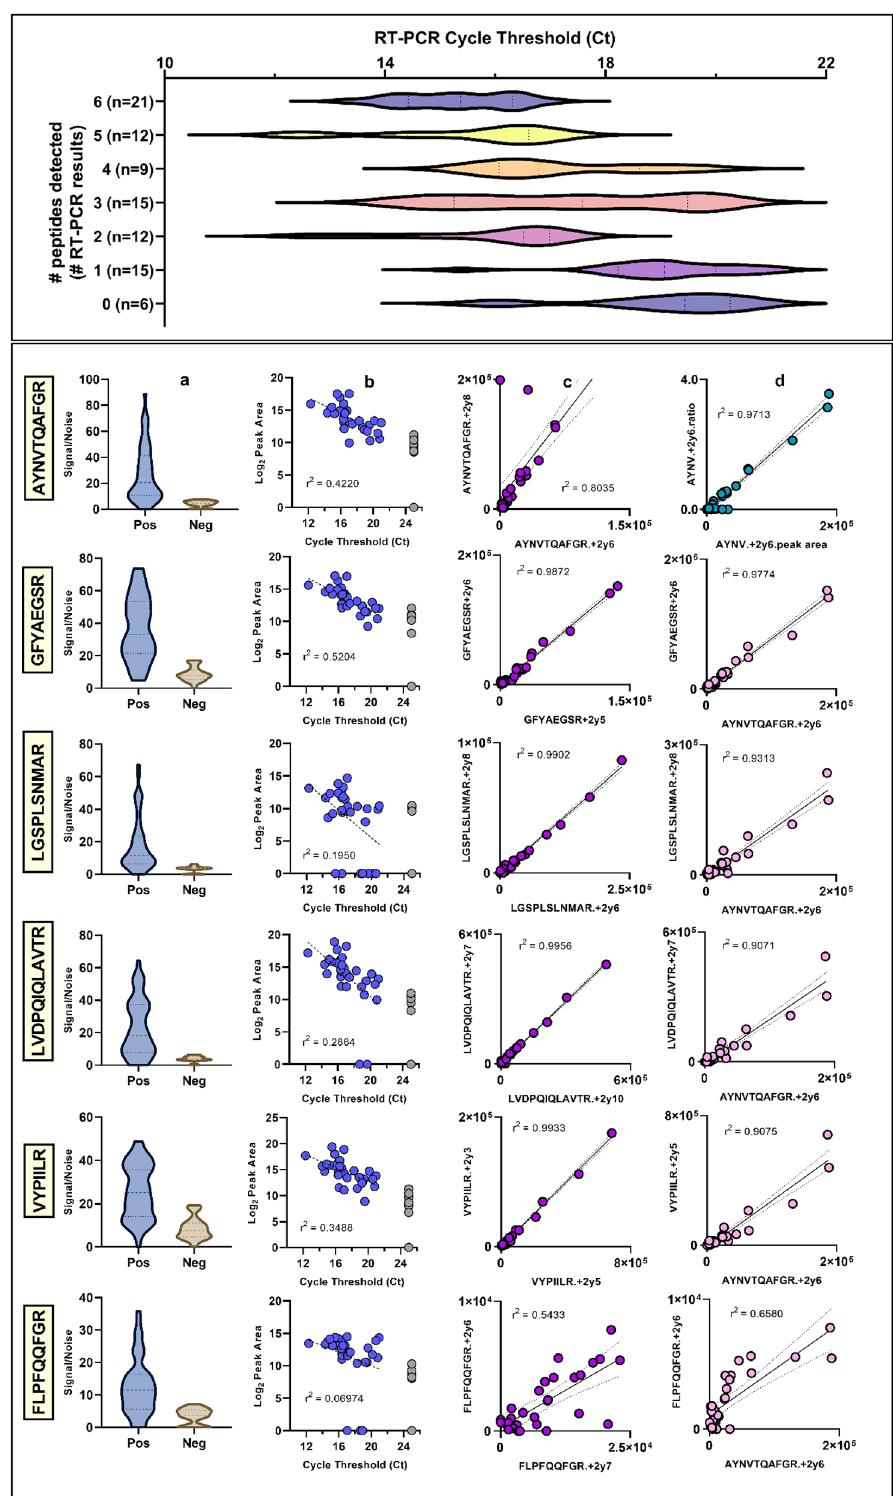
Figure 4. Targeted method performance for six peptides targeting 3 proteins from SARS-CoV-2. (Top panel) Spread of Ct values for 3 SARS-CoV-2 genes vs # peptides detected in clinical sample cohort 3. (Lower panel) From left; ( A ) Violin plot comparing software generated signal-to-noise ratio between positive (left) and negative (right) clinical specimens. ( B ) Correlation between reported N-gene Ct and peak area of the most intense MRM transition. Grey dots are peak areas detected in RT-PCR negative samples, assigned an arbitrary Ct of 25 for ease of reading. ( C ) linear regression of best two MRMs for each peptide for all RT-PCR positive samples. ( D , top panel) linear regression and correlation for raw peak area and analyte/IS peak area ratio for peptide N.AYNTQAEFGR, which has been reported in other published targeted methods. ( D , lower three panels) linear regression and correlation of other SARS-CoV-2 peptide peak areas to